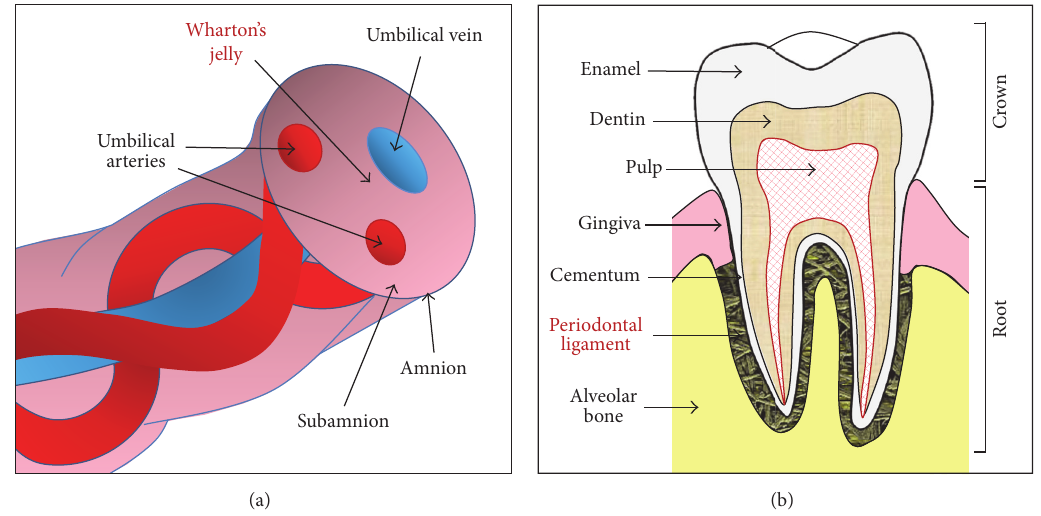
Figure1:Schematiccross-sectionaldiagramofhumanumbilicalcord(a)andtooth(b)showsanatomicalcompartments,includingWharton’s jelly (a) and periodontal ligament (b), as a source of stem cells.